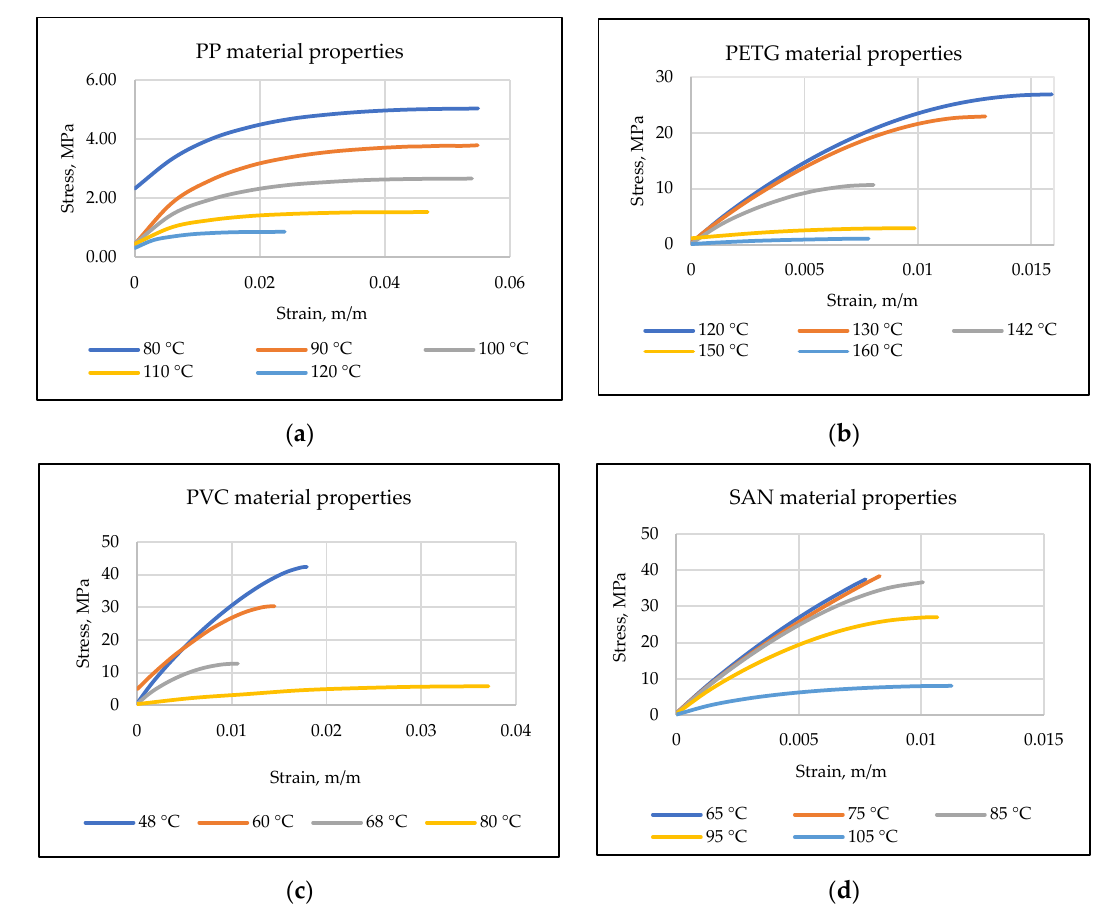
Figure 4. Stress and strain curves of ( a ) PP, ( b ) PETG, ( c ) PVC and ( d ) SAN thermoplastics. Using obtained stress – strain curves and the tangent lines, passing through the slopes, Young’s modulus for each thermoplastic was calculated defining the behavior of the ma- terial under the stress and results are given in Table 2. Thus, increasing the temperature lead to decreasing Young’s modulus for different plastics.